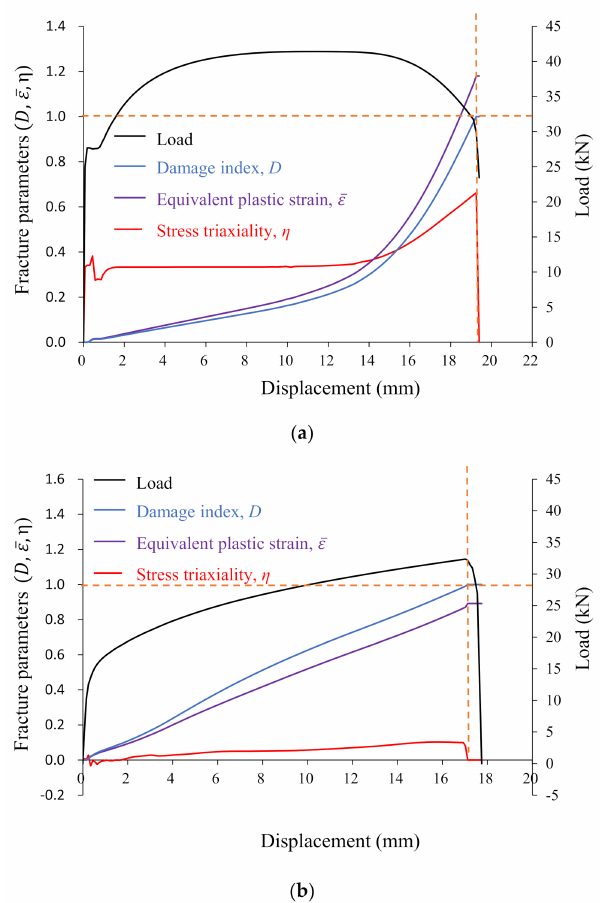
Figure 7. Relationships between fracture parameters: ( a ) Uniaxial tension specimen; ( b ) In-plane shear specimen.